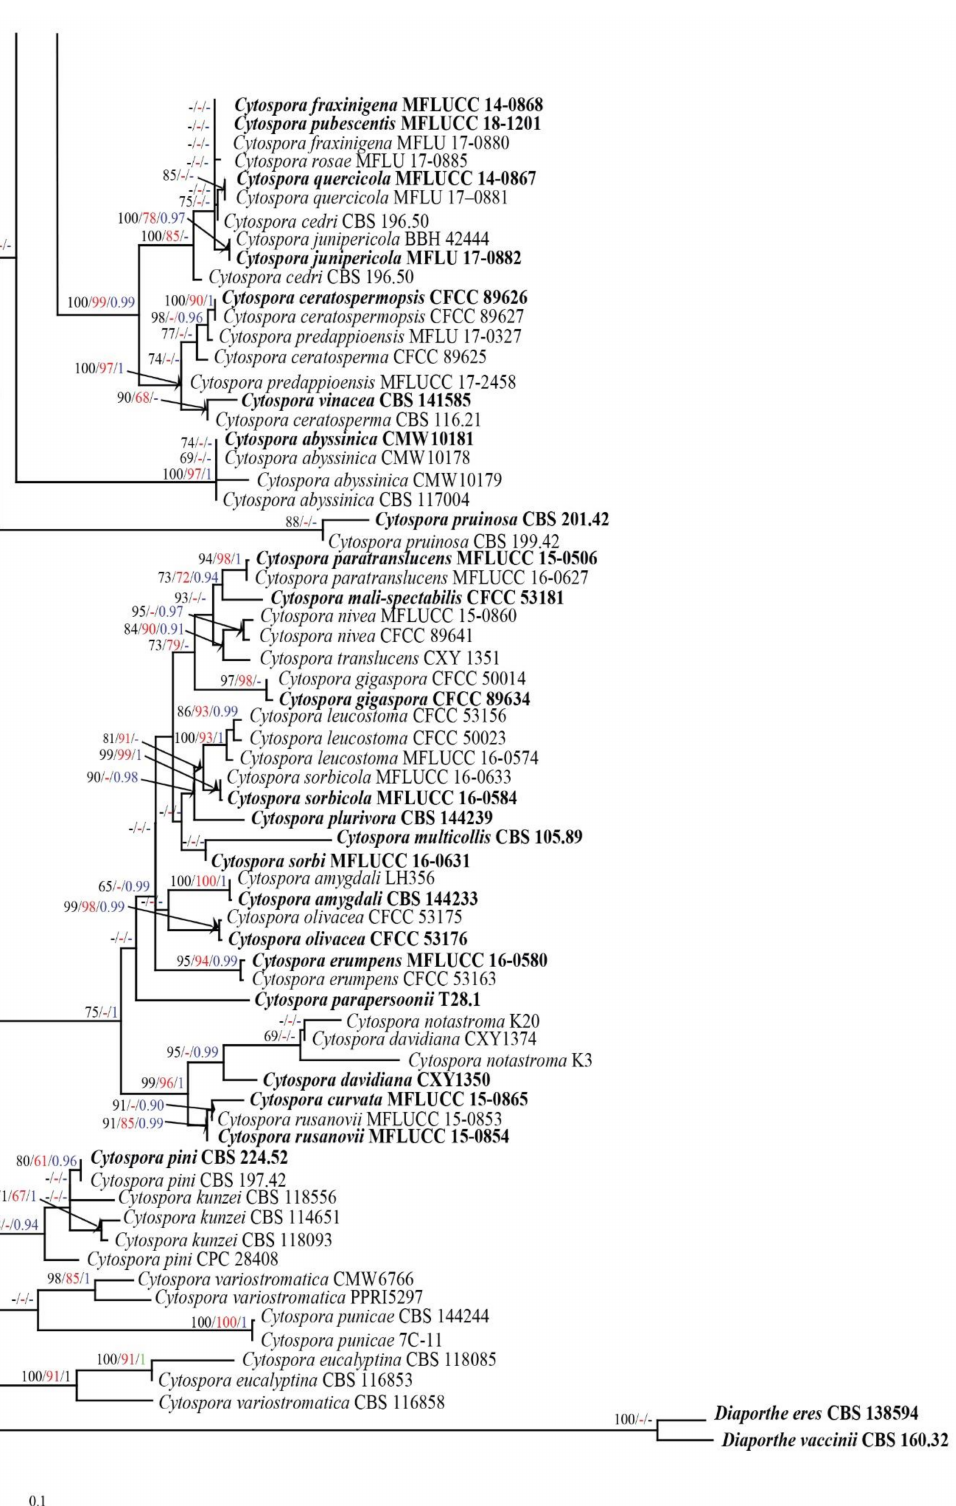
Figure 1. Phylogenetic tree obtained from RAxML analyses of a combined ITS, LSU, ACT, RPB2, TEF1- α and TUB2 sequence dataset. Bootstrap support values for ML, MP equal to or greater than 60% and PP equal to greater than 0.95 are indicated at the nodes as ML/MP/PP. The ex-type strains are in bold and the new isolates of this study are in red. The tree is rooted to Diaporthe eres (CBS138594) and D. vaccinii